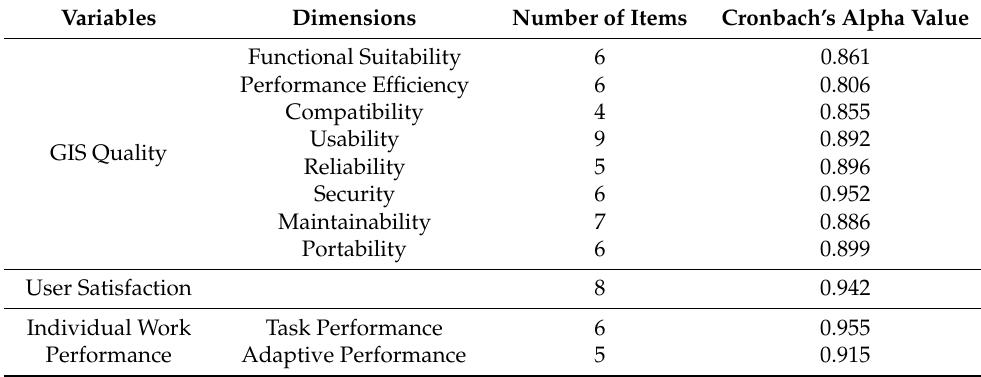
Table 4. Cronbach’s Alpha Analysis